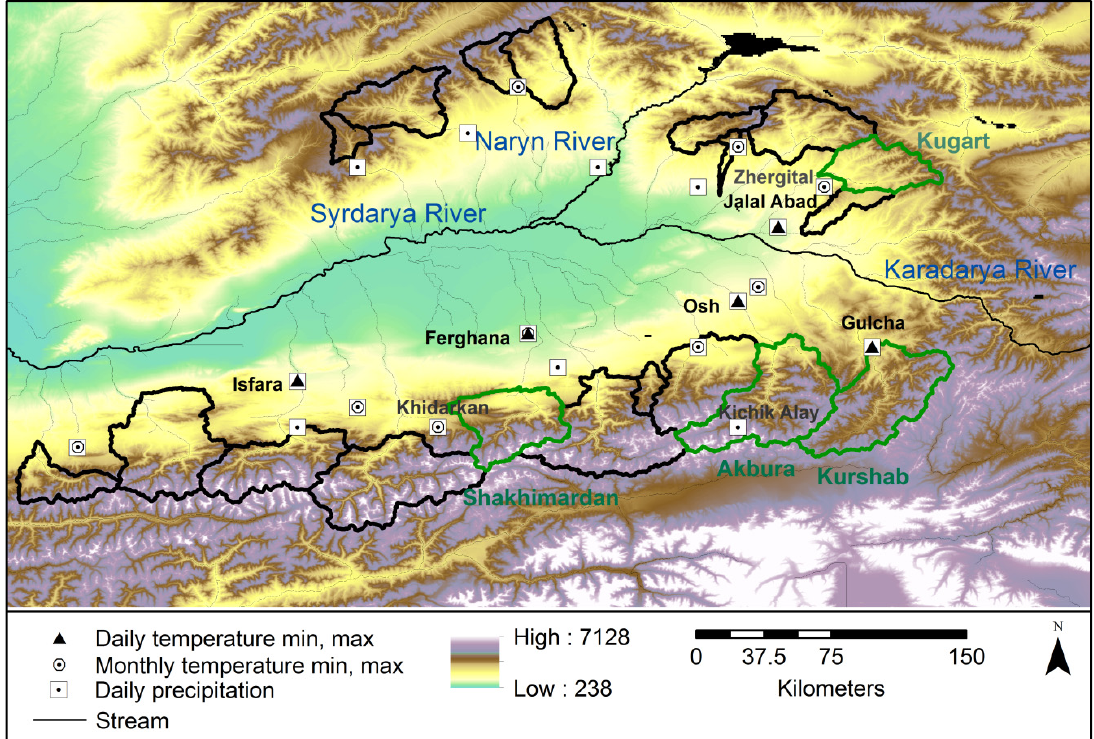
Figure 2. The Ferghana Valley with available meteorological data and four studied catchments (in